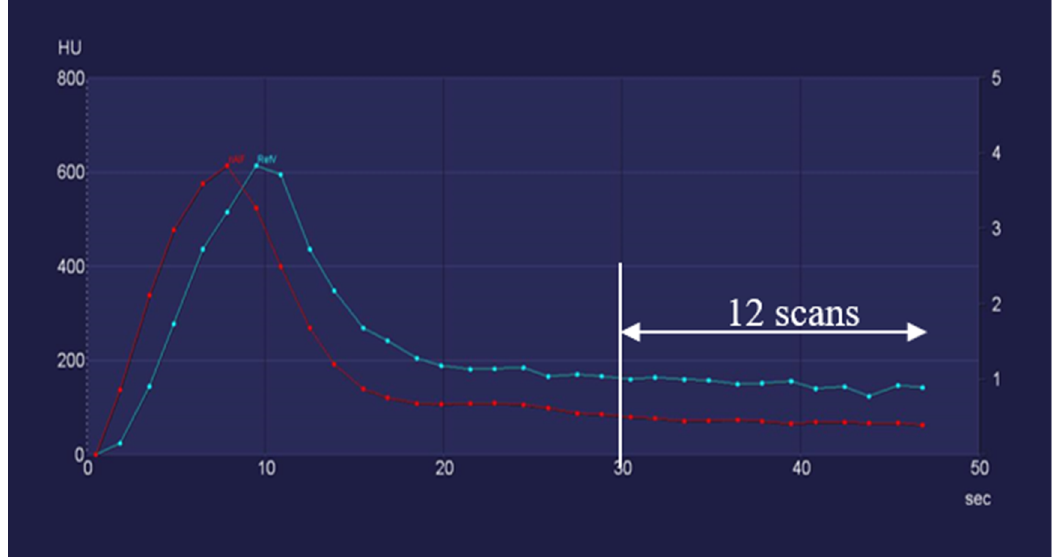
Figure 5. A shift in the ascending arterial inflow curve closer to the venous inflow curve was detected in the case of a very early contrast arrival in the ascending